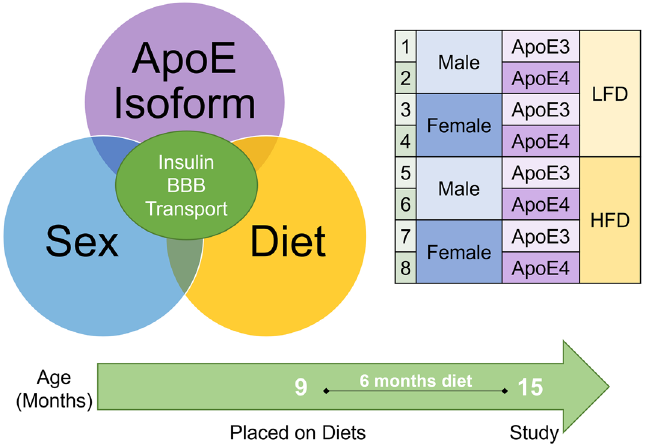
Figure 1. Schematic of the experimental design and interaction between apoE isoform, sex, and diet on insulin BBB pharmacokinetics in aged mice. Groups investigated are listed on the right side and the timeline of the study design presented on the